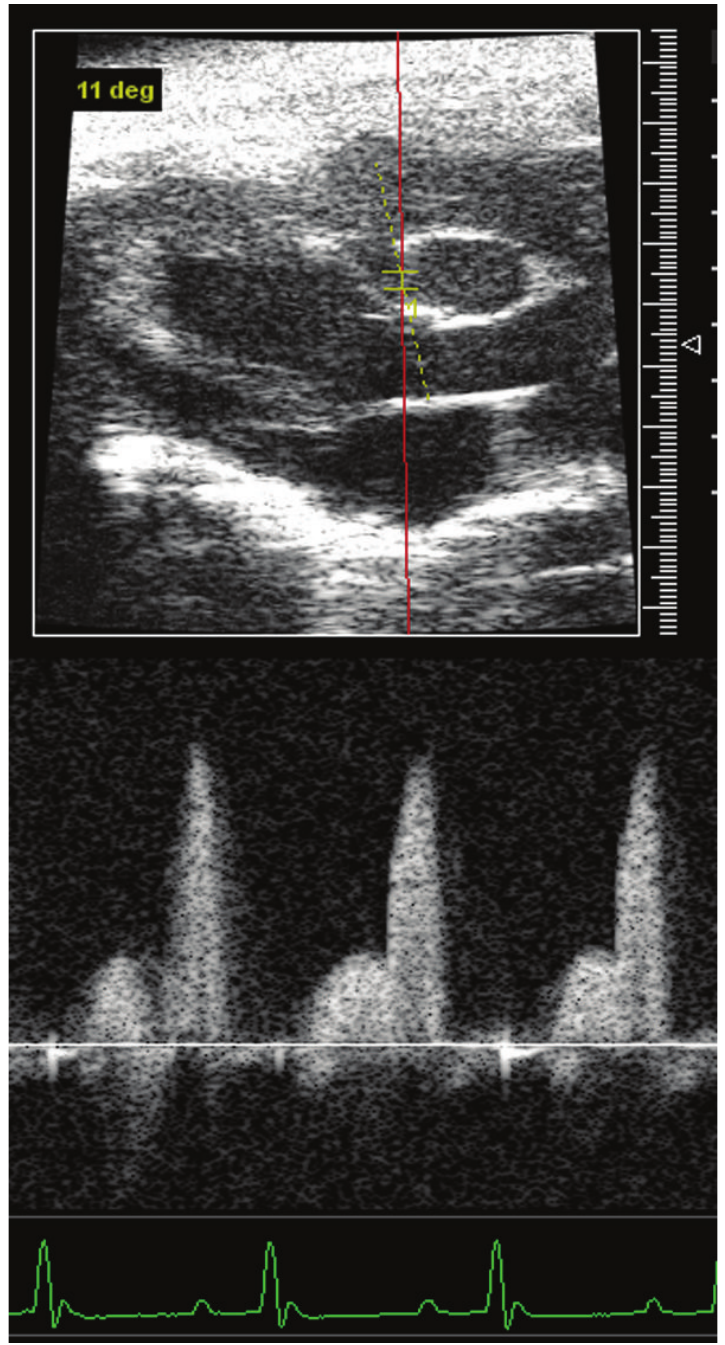
Figure 4: Coronary pulse Doppler tracings obtained on a wild-type